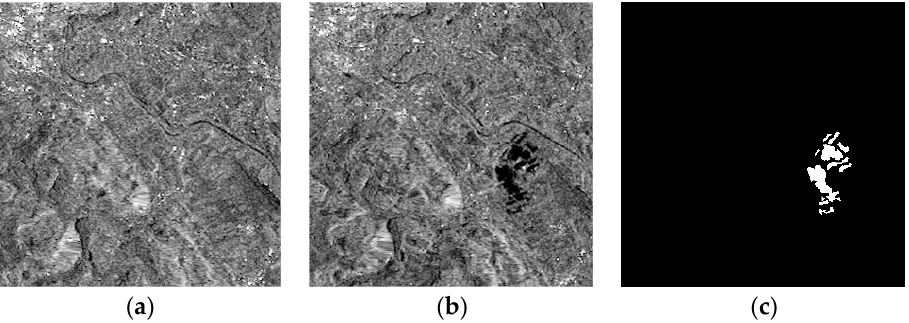
Figure 3. Bern data set: ( a ) Image acquired in April 1999; ( b ) Image acquired in May 1999; ( c ) The reference change image.